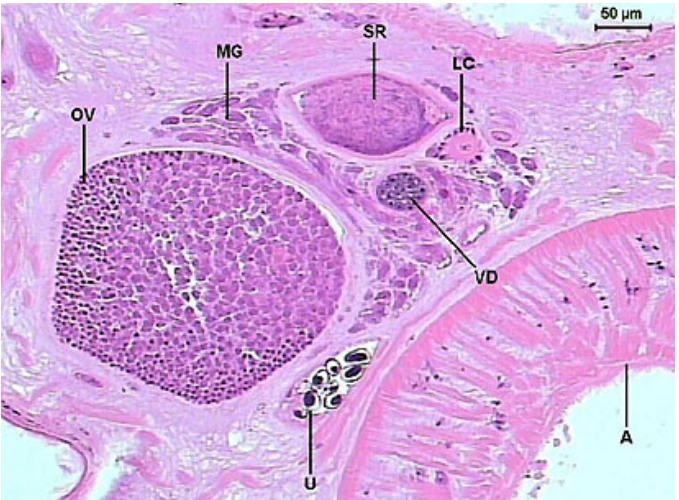
Figure 15. Transversal section of the ovary and Mehlis’ gland of the Sticholecitha serpentis. MG – Mehlis gland, SR – seminal receptacle, LC – Laurer’s channel, OV – ovary, VD – vitelline duct, U – uterus.